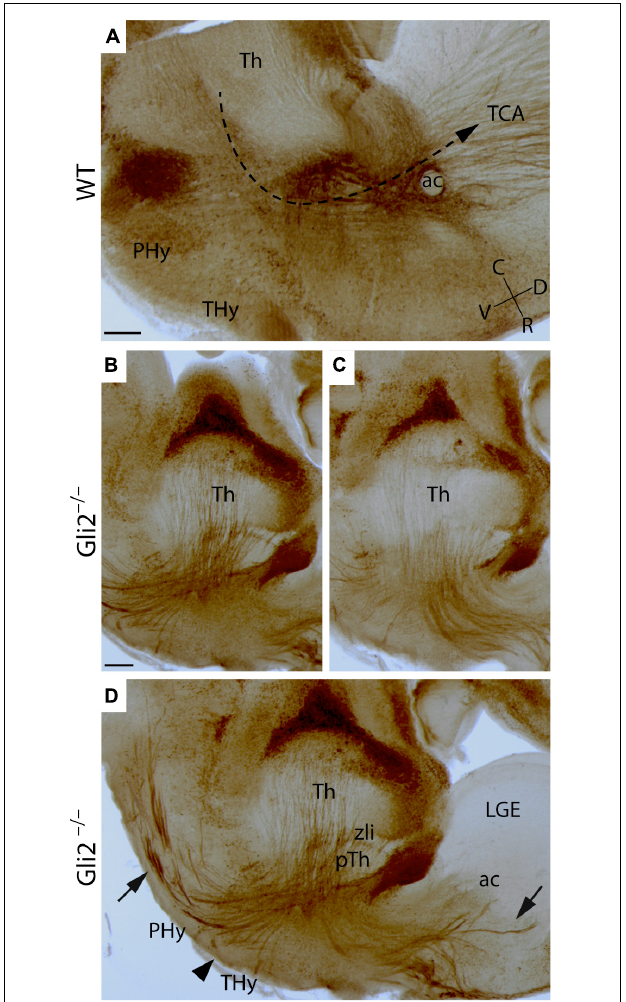
FIGURE 1 | Thalamocortical axonal trajectory in Gli2 mutant mice embryos. Sagittal sections through wild-type WT (A) and Gli2 mutant (B–D) E18.5 embryos with a immunohistochemistry against calretinin. (D) Is a merge of images displayed in (B,C) to better illustrate the TCAs dispersion. In (A) , the dotted arrow indicates the direction of the TCAs trajectory in the WT. The arrows indicate the aberrant trajectory of TCAs to the caudal and rostral region. The arrowhead indicates the axons directed toward the hypothalamus. ac, anterior commissure; C, caudal; D, dorsal; Hy, hypothalamus; LGE, lateral ganglionic eminence; PHy, peduncular hypothalamus; pTh, prethalamus; R, rostral; THy, terminal hypothalamus; TCA, thalamocortical axons;